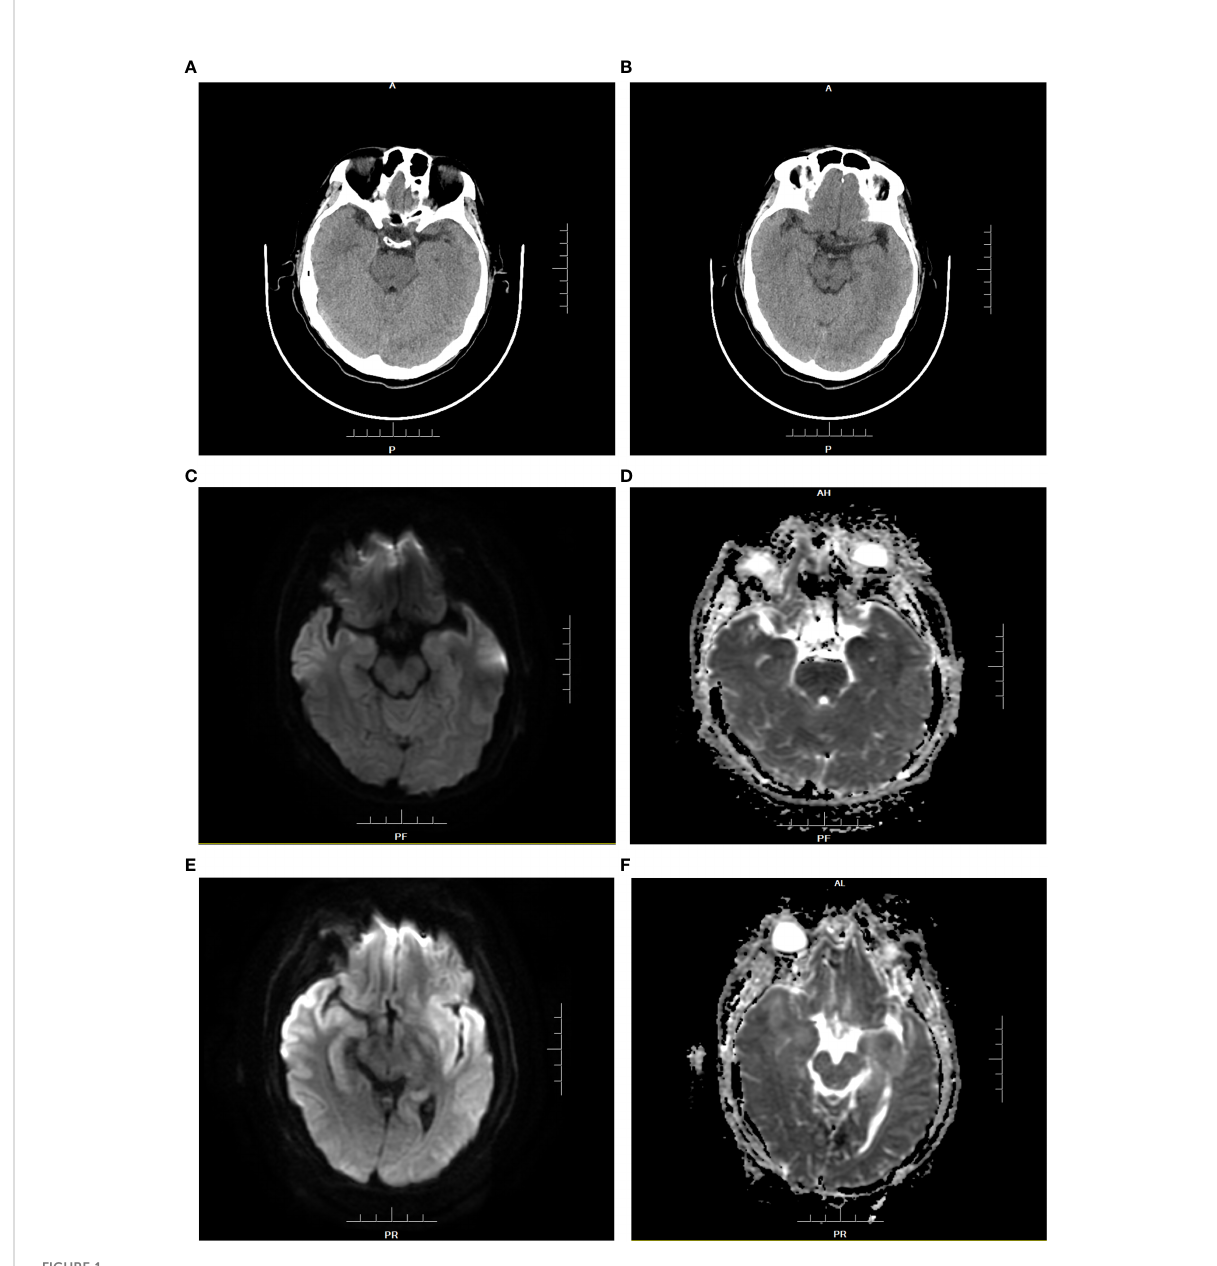
FIGURE 1 Brain CT and MRI of patient 1 before medication (A – D) . (A, B) : The density of the inferior pole of both the temporal lobes was slightly decreased. (C) : DWI showed that white matter signals under the gray matter of the inferior temporal pole were limited on both sides. (D) : ADC showed symmetrical low signal changes.Brain MRI fi ndings of patient 1 at the diagnosis of HHV-6B encephalitis (E, F) . (E) : DWI showed that bilateral inferior temporal poles were diffusively limited and symmetrical, with upwards involvement of the bilateral basal ganglia and subgray matter region of the medial lateral temporal lobe. (F) : ADC presented high signal